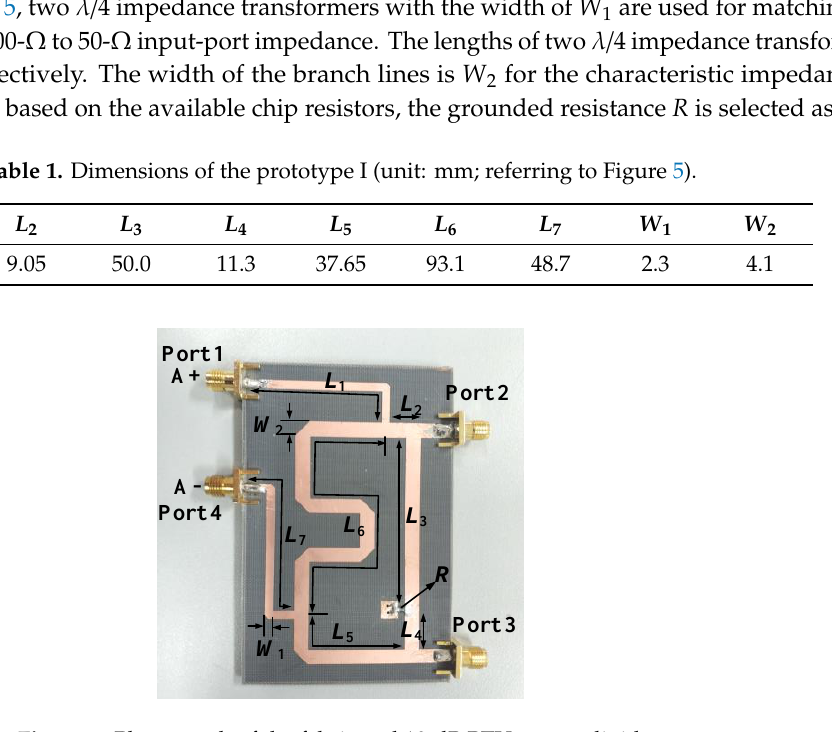
Figure 5. Photograph of the fabricated 10-dB BTU power divider.